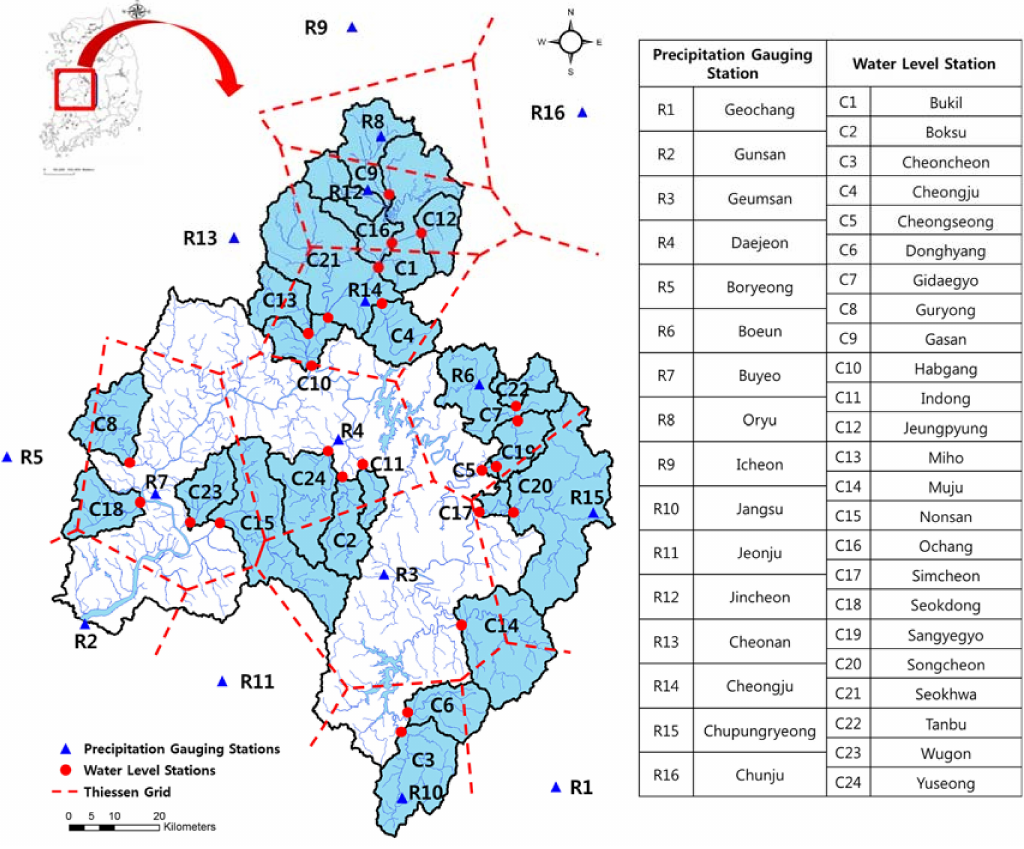
Figure 1. Study catchments; Geum River region,